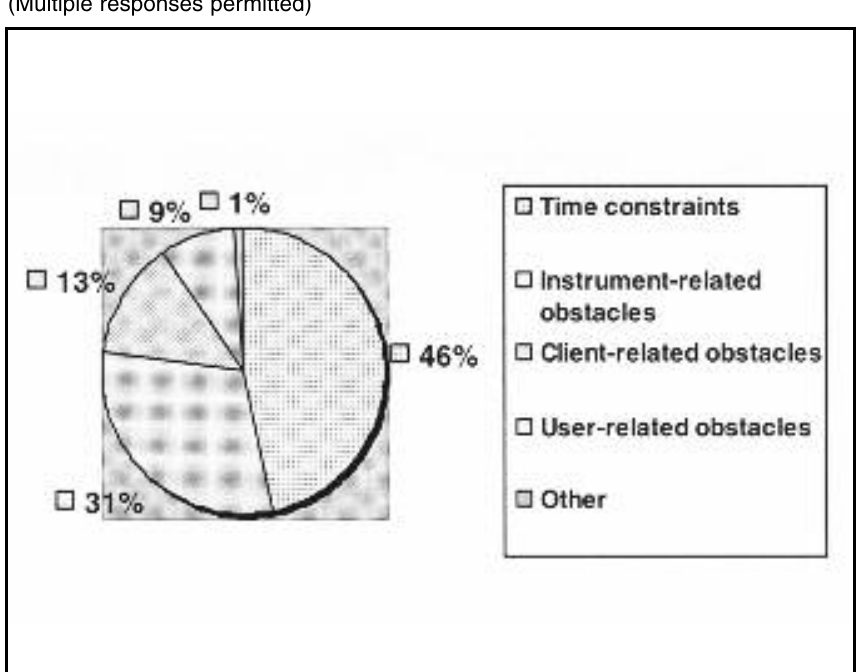
Figure 3: Perceived obstacles to the use of outcome measures (Multiple responses